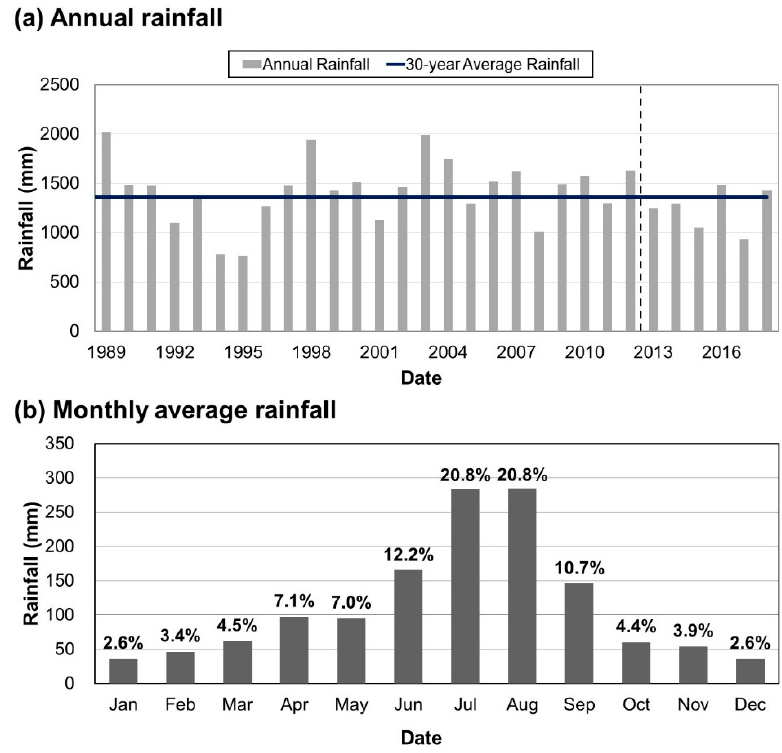
Figure 3. Annual ( a ) and monthly ( b ) variations of rainfall in the study areas.